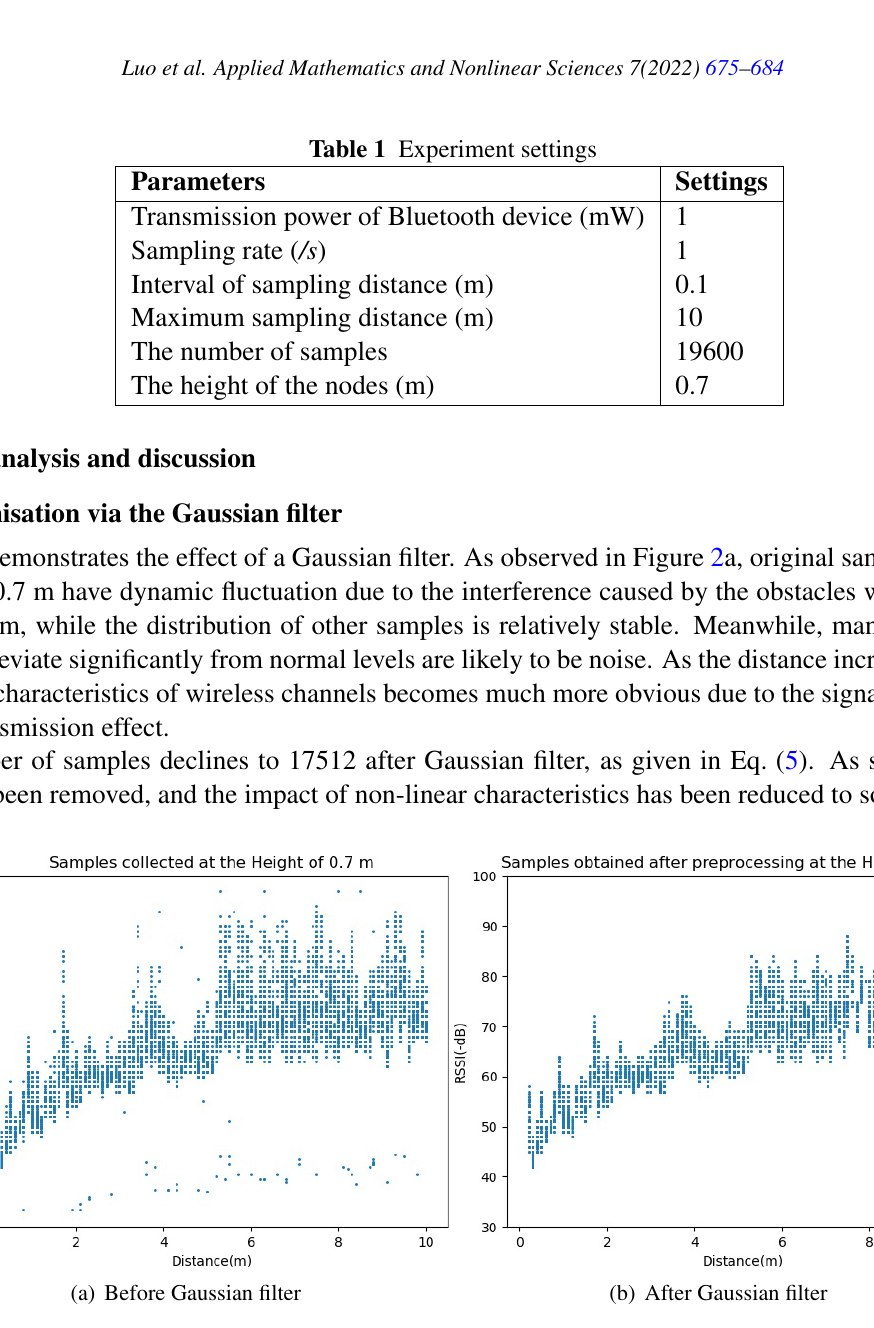
Fig. 2 Comparison of samples before and after Gaussian